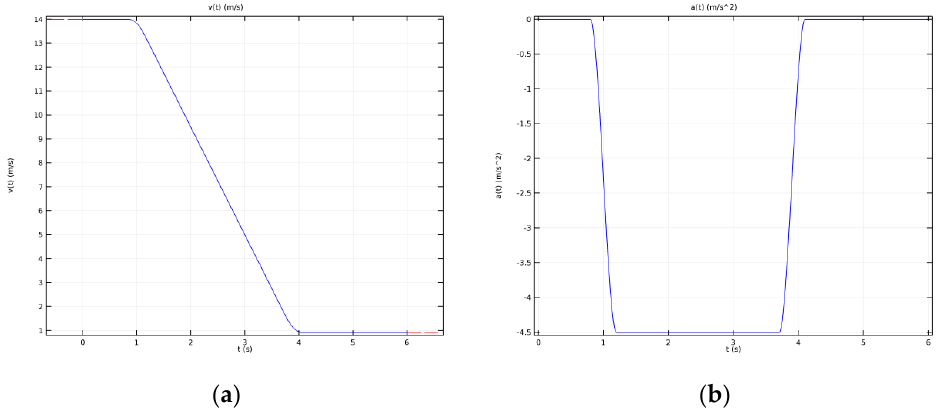
Figure 15. Tachogram of ( a ) speed and ( b ) deceleration during emergency braking.